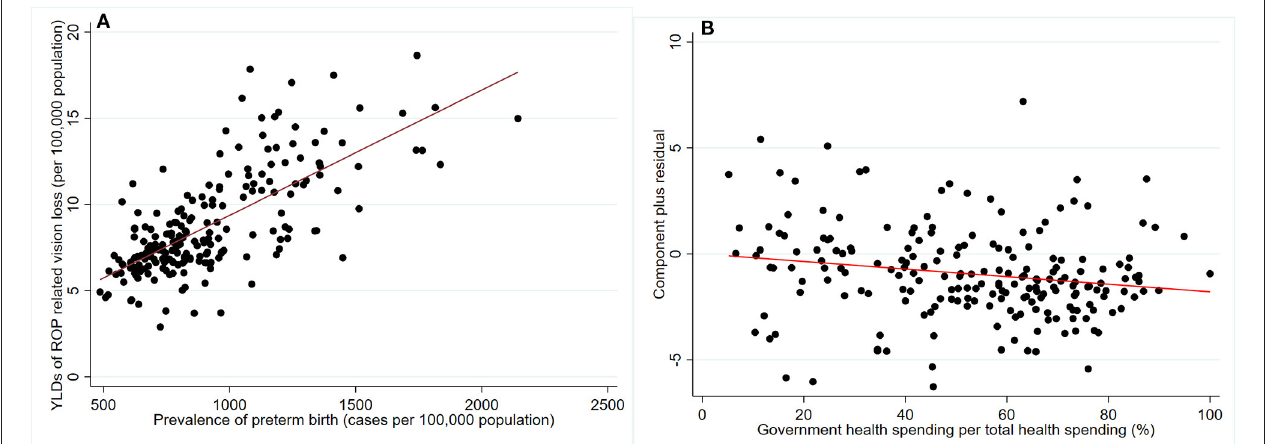
FIGURE 4 | Scatter plot and linear prediction of YLDs related to retinopathy of prematurity. (A) association between preterm birth prevalence and ROP-related vision loss burden among 204 countries and territories; (B) association between government health spending per total health spending (%) and ROP-related vision loss burden among 204 countries and territories, adjusted for preterm birth prevalence.